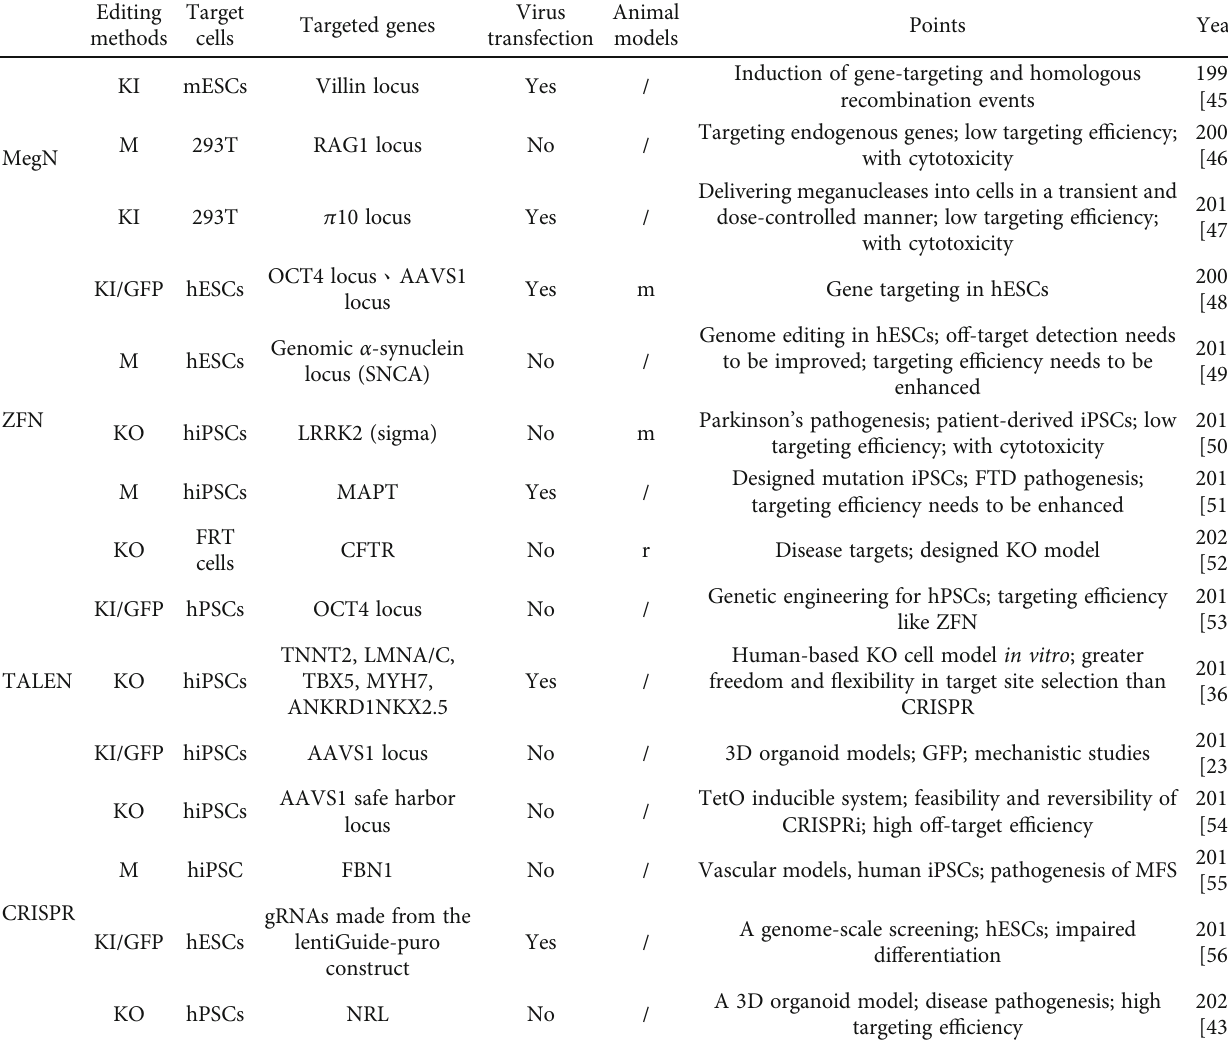
Table 2: Landmarks and trends of gene editing in life and medical